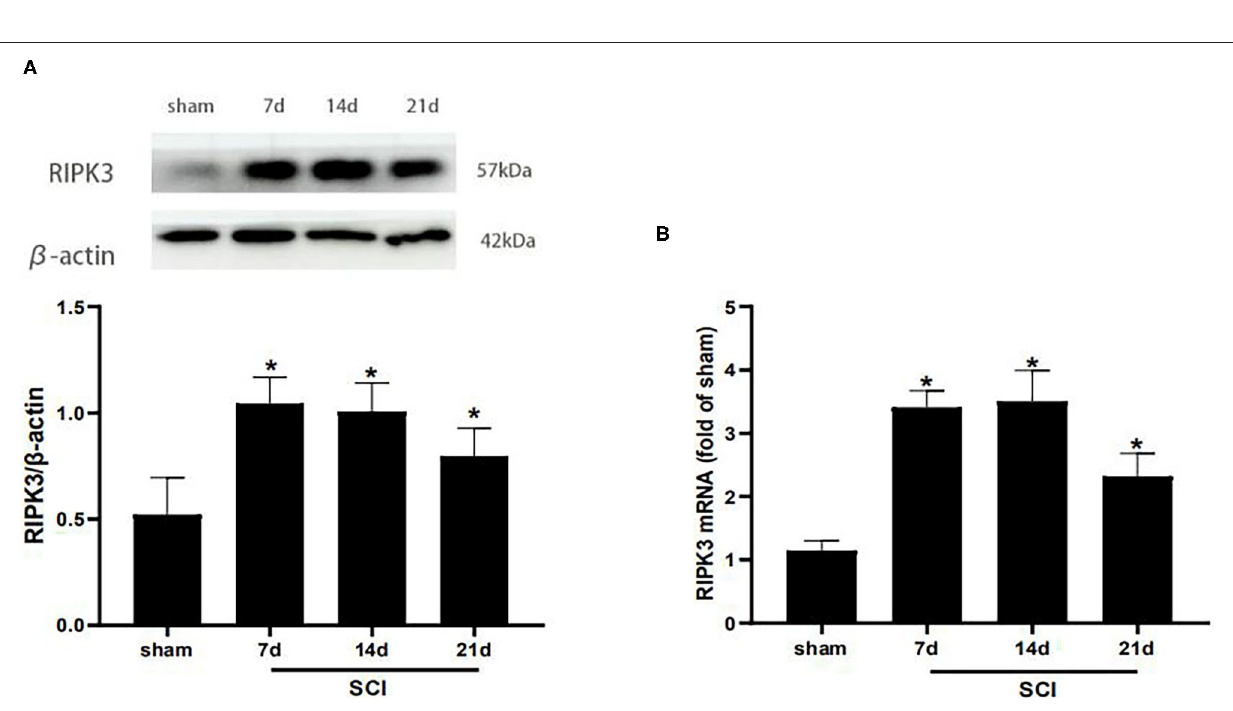
Frontiers in Molecular Neuroscience |